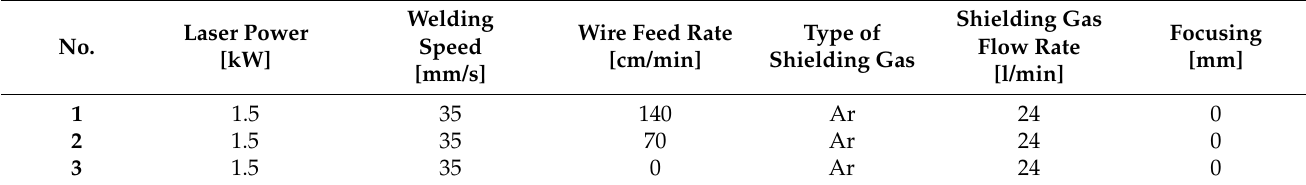
Table 4. Welding